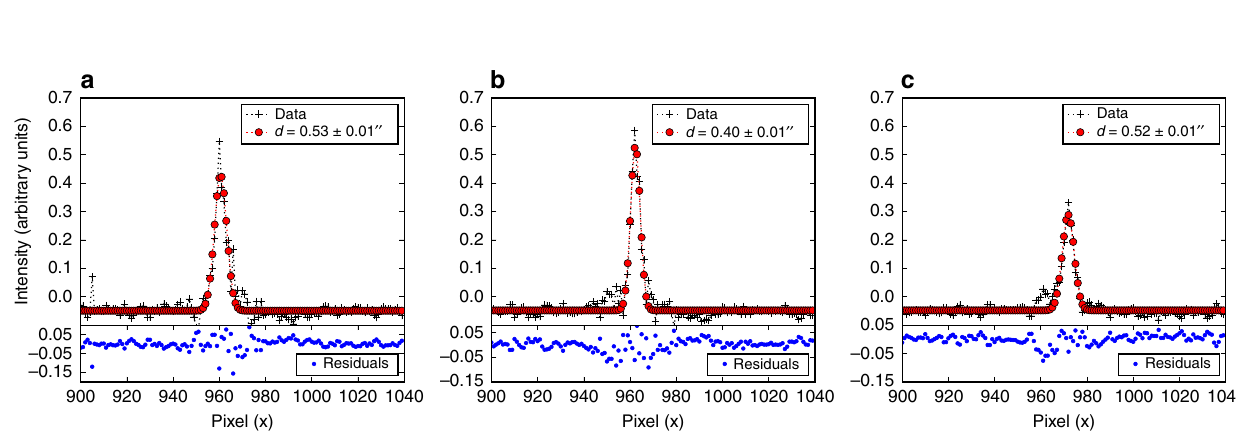
Fig. 4 Gaussian fi tting to the jet width using the HST [Fe II] 1.644 μ m continuum-subtracted image. Black data points are the data, red data points are the best Gaussian fi t, and the blue dots are residuals from the fi t. Best fi t values for the jet width are indicated in the fi gure legend for the K2 – K4 knots in panels ( a ) – ( c ),